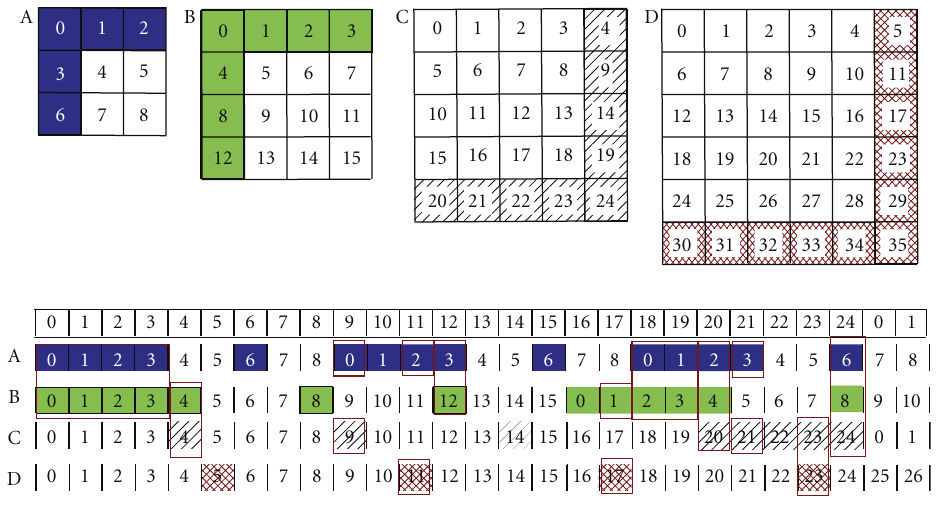
Figure 5: Legal quorum intersections with di ff erent grid